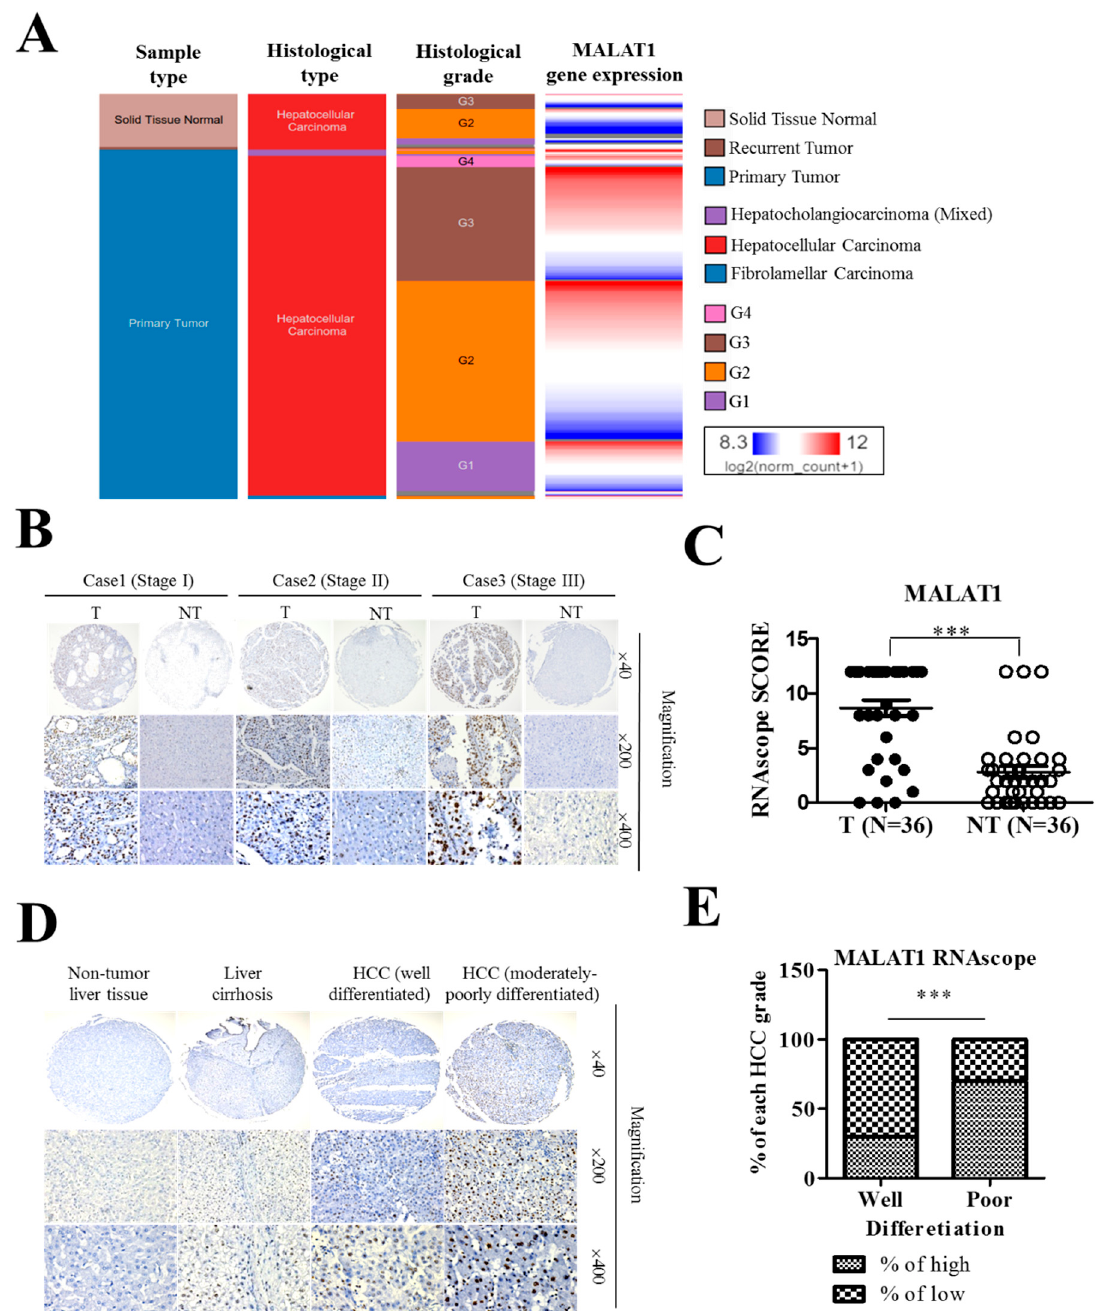
Figure 2. LncRNA MALAT1 overexpression in liver cancer positively correlates with poor cellular differentiation status and disease progression. ( A ) In the TCGA liver cancer (LIHC) cohort (n = 438) significantly positive correlation between MALAT1 expression and cellular differentiation (histologic) grade was observed. G1, grade 1 = well differentiated; G2, grade 2 = moderately differentiated; G3, grade 3 = poorly differentiated; G4, grade 4 = undifferentiated/anaplastic. ( B ) Representative RNAscope images (T = Tumor; NT = Non-tumor) and ( C ) Boxplots graph depicting the manual scores showing positive correlation between increased expression of MALAT1 and HCC pathological stage. ( D ) Representative RNAscope images and ( E ) stacked histogram showing the differential expression of MALAT1 in non-tumor liver tissue, liver cirrhosis, well-differentiated HCC and moderately-poorly differentiated HCC tissues. *** p < 0.001.